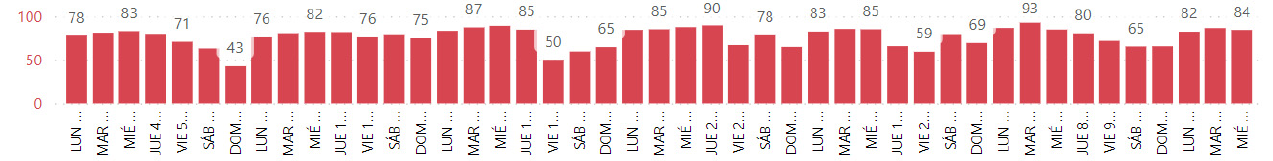
Figure 8. Percentage of daily mobility using public transport in Cartagena in March and April 2021 compared to the same days in 2019. Data source: Ministry of Transport of Spain and Cartagena City Council.